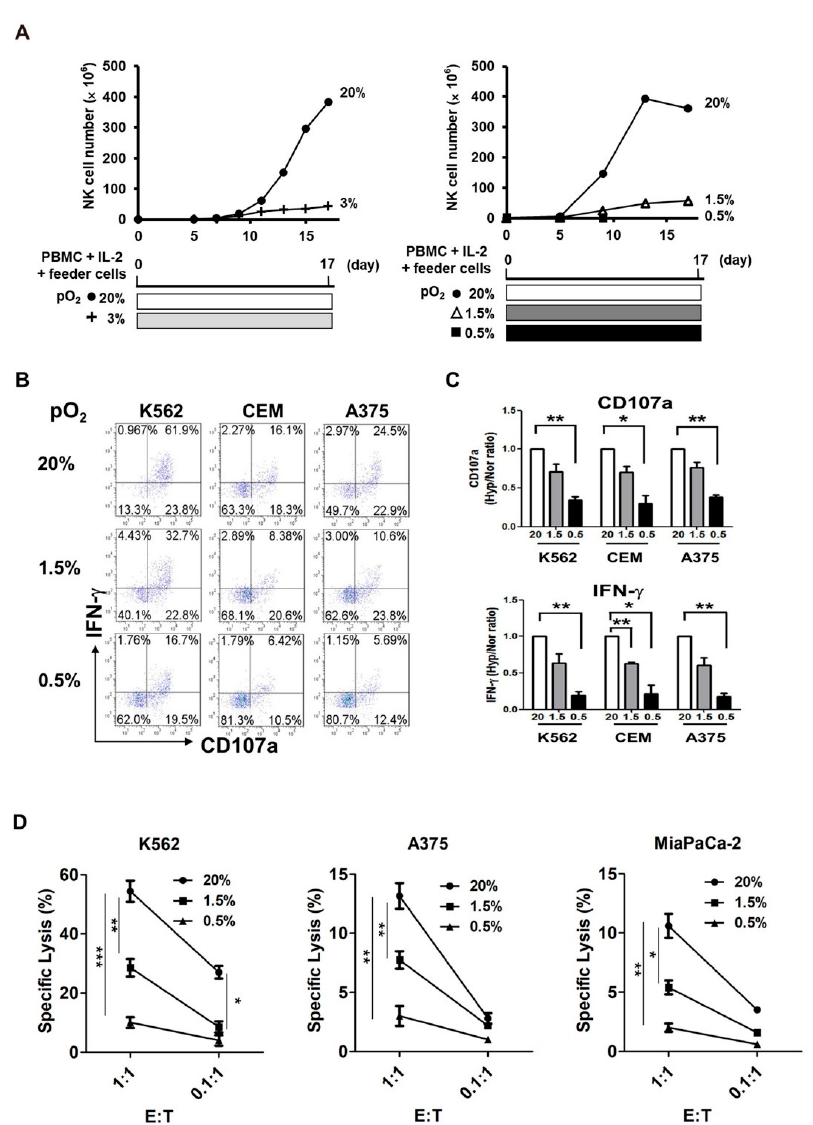
Figure 1. Hypoxic exposure of resting NK cells impairs their proliferation and anti-tumor activities ex-vivo. ( A ) Time course of NK cell expansion under different pO 2 conditions. PBMCs were isolated from peripheral blood and co-cultured with irradiated KL-1 and LCL feeder cell lines at a ratio of 1:0.5:0.5 in presence of 500 U/mL IL-2 under different pO 2 conditions (20, 3, 1.5, and 0.5%) for 21 days. Due to limited availability of hypoxic chamber, 3 and 1.5% hypoxia experiments were performed separately. ( B ) Representative FACS plots ( n = 3) demonstrating CD107a expression and intracellular IFN- γ content of NK cells cultured under different pO 2 conditions. PBMCs were exposed to different pO 2 conditions (20, 1.5, and 0.5%) for 96 h, along with feeder cells and IL-2, and CD107a degranulation and IFN- γ production by NK cells were measured by FACS after incubating the PBMCs with target tumor cells under normoxic condition for 6 h. ( C ) The ratios of CD107a+ or IFN- γ + NK cells in normoxic vs. hypoxic condition from three independent experiments are plotted as bar graphs. ( D ) NK cell tumor cytotoxicity observed after 96-h incubation with target cells under different pO 2 conditions (20, 1.5, and 0.5%) was determined by LDH cytotoxicity detection kit. LDH activity released from the cytosol of damaged tumor cells was measured after incubating purified NK cells with target cells under normoxic condition for 4 h. The percentage of specific lysis was calculated as follows: [((abs 492 nm effector/target mix − abs 492 nm effector only) − abs 492 nm spontaneous)/(abs 492 nm maximum − abs 492 nm spontaneous)] × 100. Data are presented as the mean ± SEM from three independent experiments. *, p < 0.05; **, p < 0.01; ***, p <